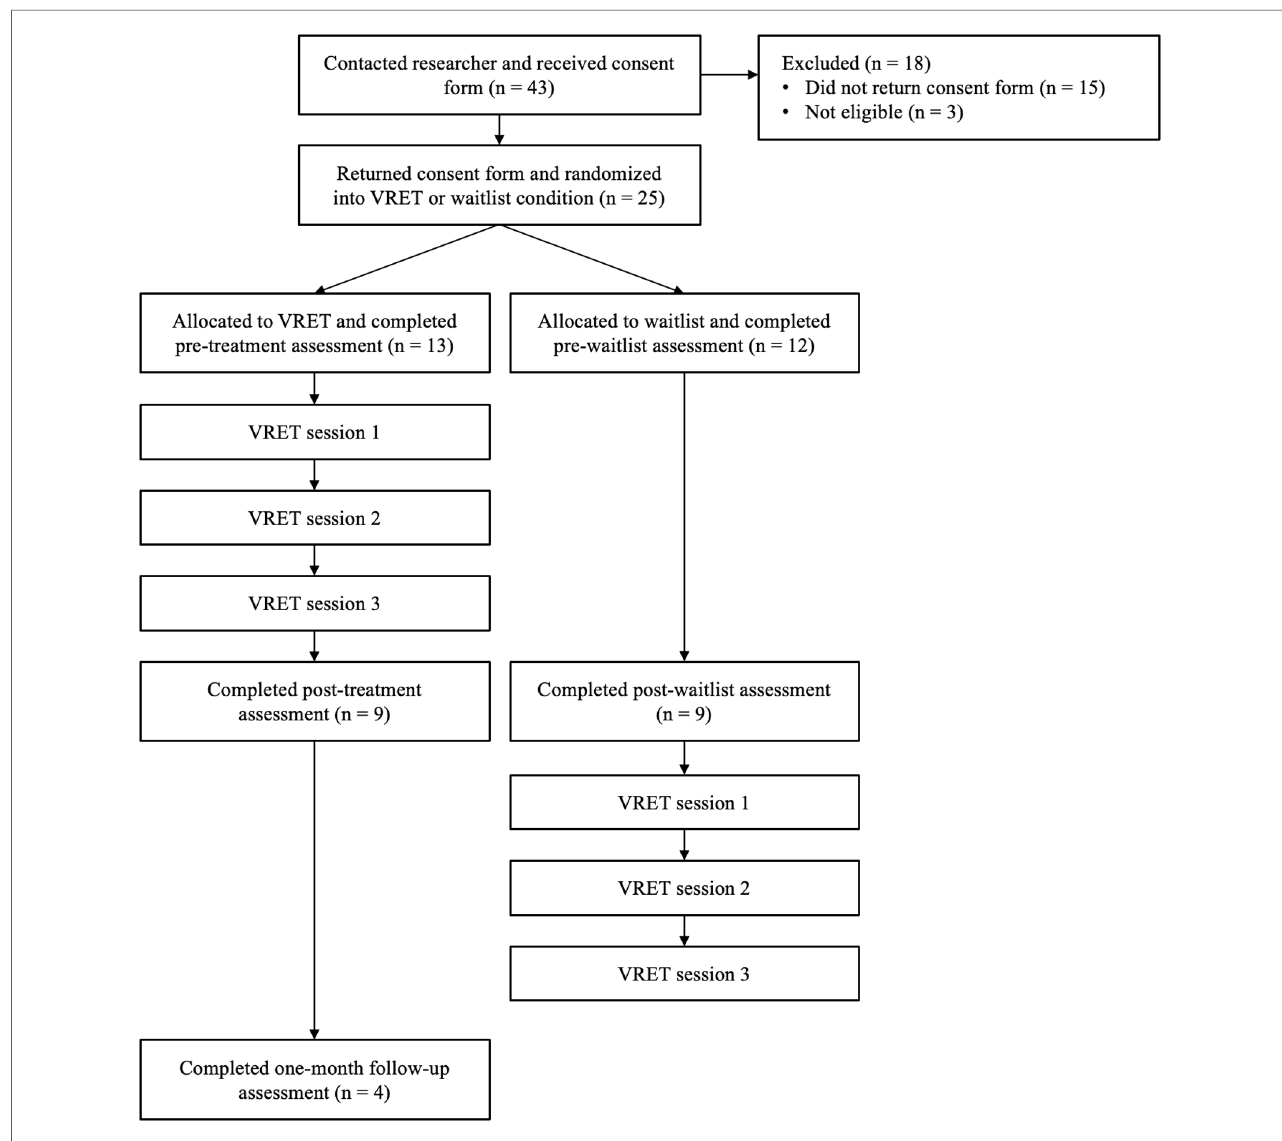
FIGURE 1 Flow diagram illustrating experiment